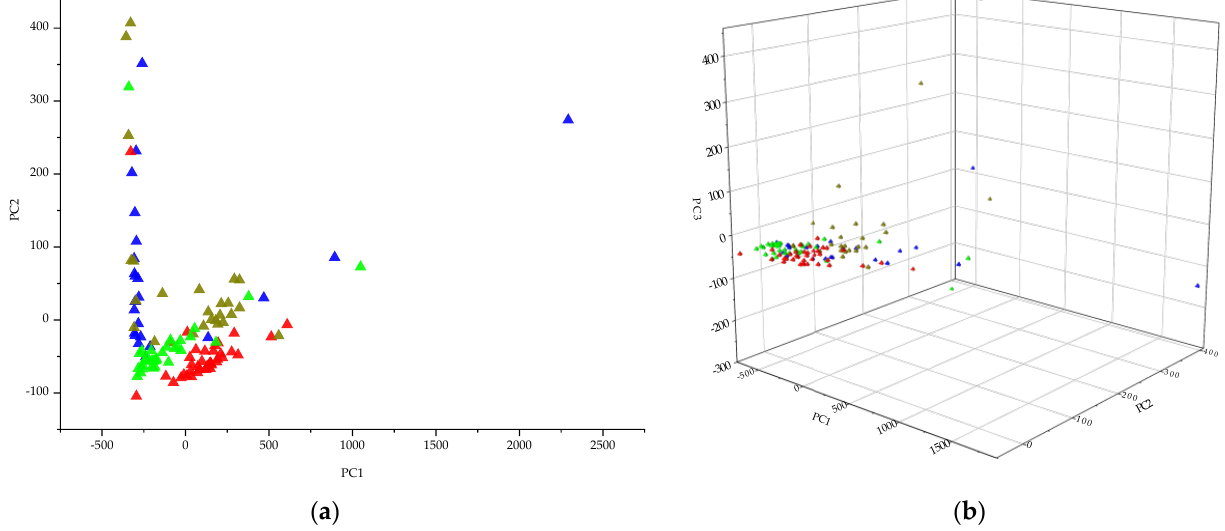
Figure 4. Distributions of the principal components output by PCA. Points in the same color were generated with samples of the same perfume type. ( a ) PC1 and PC2 when the output feature dimension of PCA is set as 2 ( d ′ = 2); ( b ) PC1, PC2, and PC3 when the output feature dimension of PCA is set as 3 ( d ′ = 3).